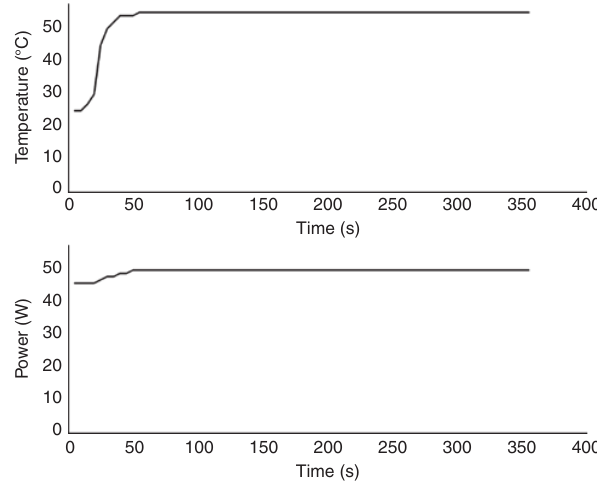
Figure 1: The variation in the temperature and power (P) in the reaction system during the transesterification under the MWHCC condition (T = 55 ° C and P = 50